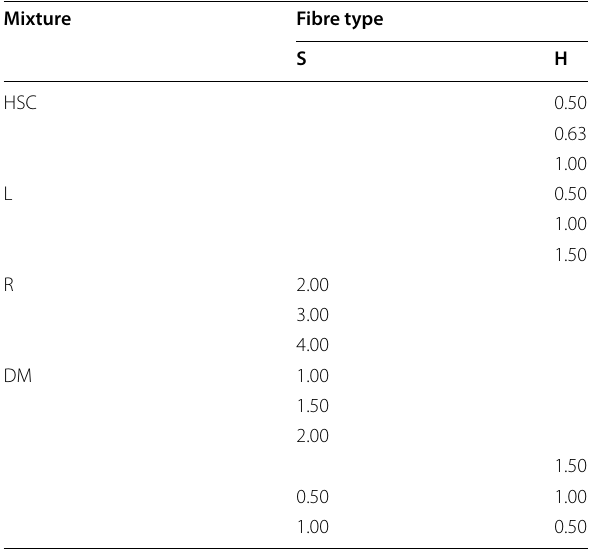
Table 2 Fibre volumetric contents. Fibres: S—straight 13 mm ×